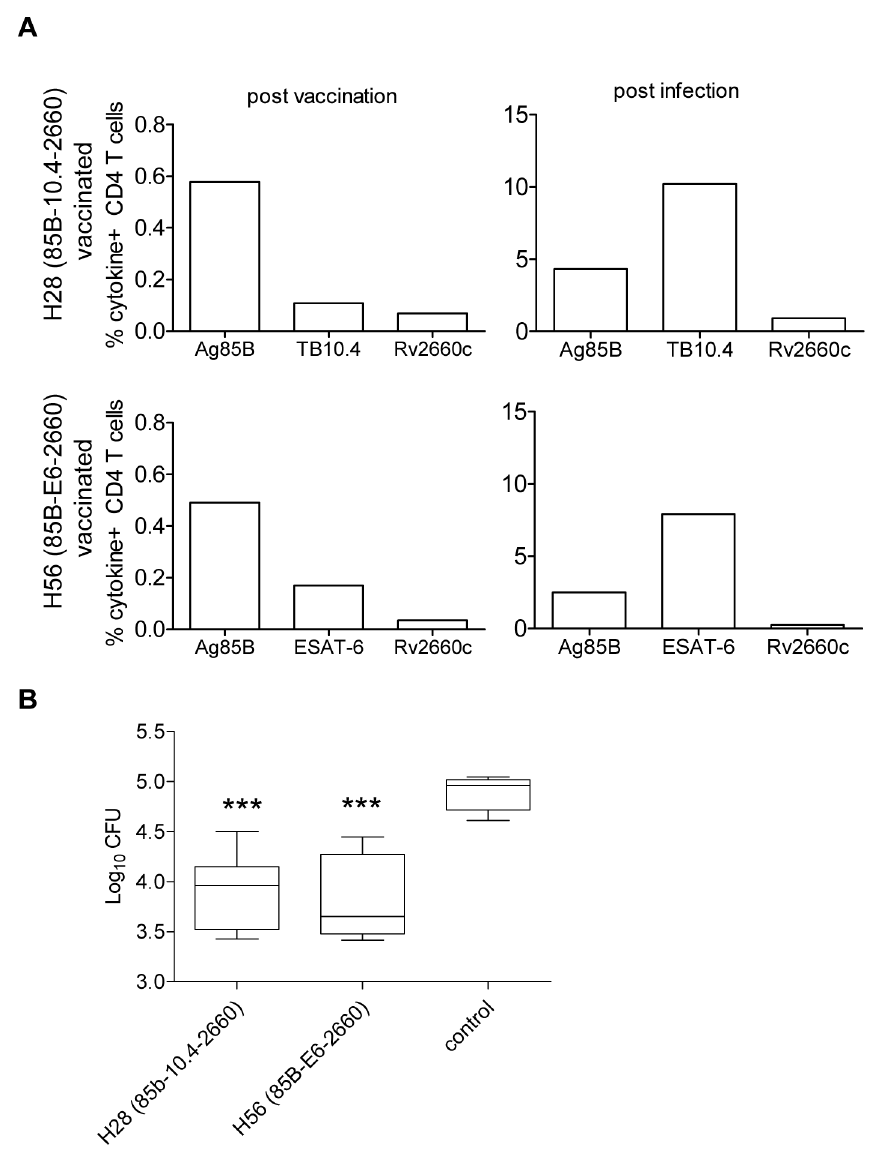
Figure 3. Prophylactic vaccination with H28 and H56 result in similar levels of protection. Groups of CB6F1 mice were vaccinated three times with two weeks interval with H28 or H56 formulated in CAF01 or with CAF01 alone. (A) Two weeks following vaccination with either H28 or H56, PMBCs (pooled from six mice) were stimulated with Ag85B, TB10.4, ESAT-6 or Rv2660c and antigen specific responses assessed by flow cytometry. The frequency of cytokine producing CD4 T cells expressing IFN-γ, IL-2 or both cytokines was determined by intracellular staining for cytokines (ICS). Lung lymphocytes (pooled from six mice) were obtained after six weeks of infection and the frequency of cytokine producing CD4 T cells determined by ICS. Data are representative of three experiments. (B) Protection was assessed at week 6 post infection by culturing lung homogenates and enumerating bacteria (expressed as log ). Data displayed are box and whiskers of six mice and minimum and maximum CFU levels. As a negative 10 control, a group of mice received CAF01 only. Values marked with an asterisk are significantly different from naïve control animals as assessed by ANOVA and subsequent Tukey’s multiple-comparison test (***, p <0.001). The data are typical for several experiments as illustrated in Table